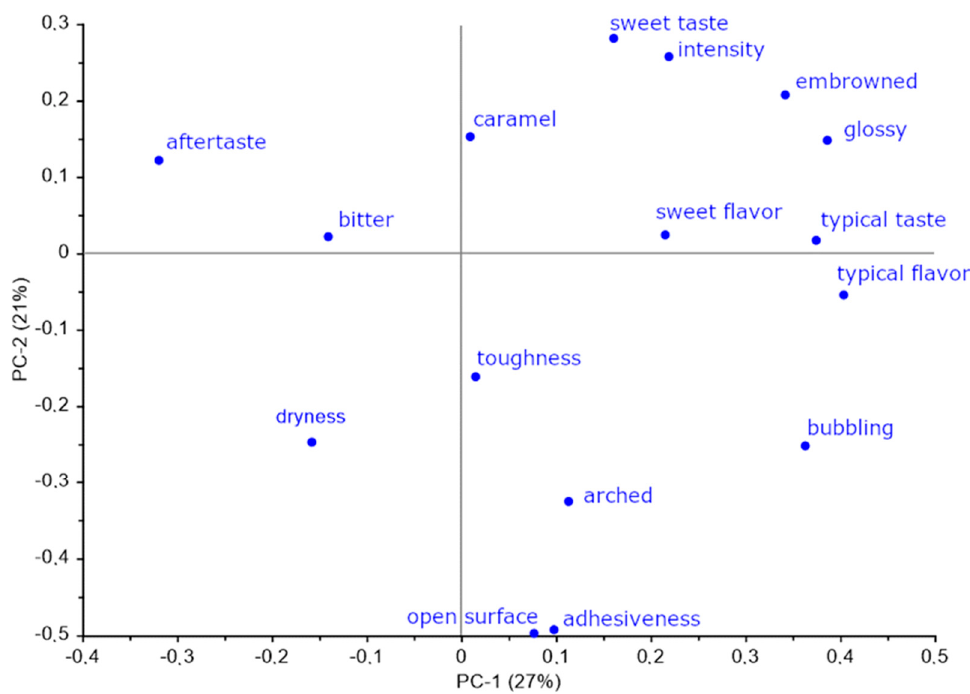
Figure 11. PCA loading plot of sensory attributes of muffin samples.